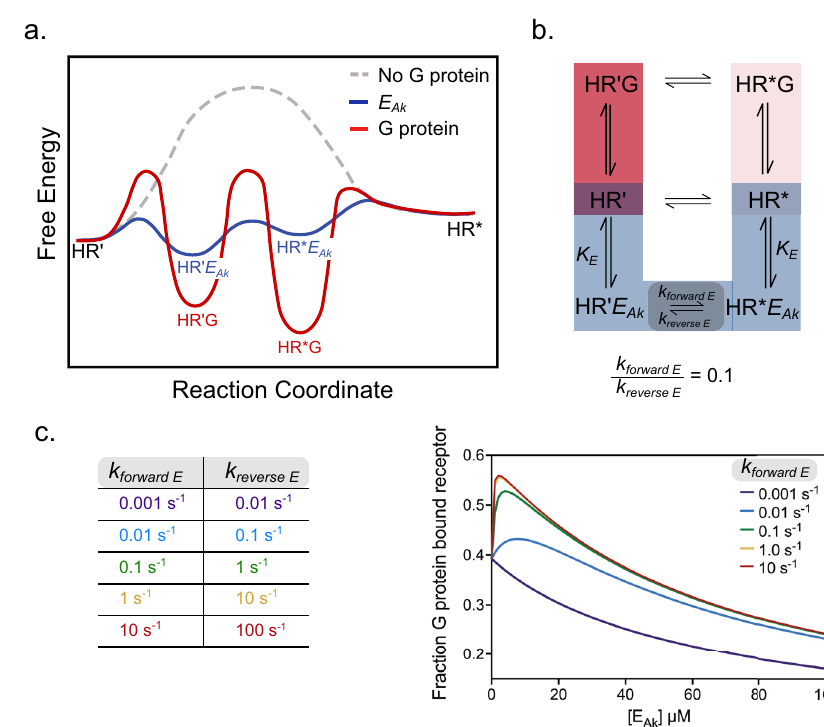
Fig. 4 Allokairic modulation decreases the activation barriers for G protein ternary complex formation. a Free-energy diagram showing transitions between receptor states. b Extended model showing the dissociation (K E ) of the allokairic effector ( E Ak ) and the forward and reverse rates for receptor interconversion by E Ak . c Simulations varying the speed of receptor interconversion rates with E Ak present show the interconversion rates determine effect of the E Ak on ternary complex formation with 10 μ M G protein present. Source data are provided in the Source Data